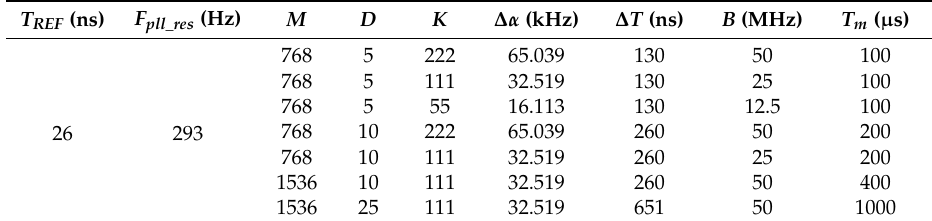
Table 2. Parameters of the FSG block for FMCW operation.